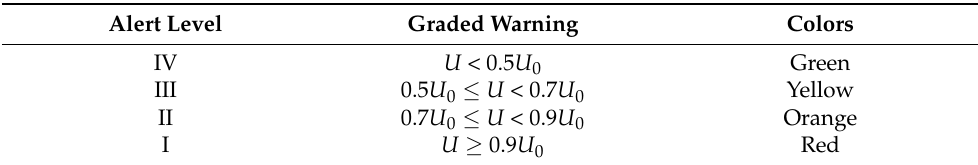
Table 2. The graded warning thresholds of Yongjiang immersed tunnel (revised according to the results of Xie et al. [26]).